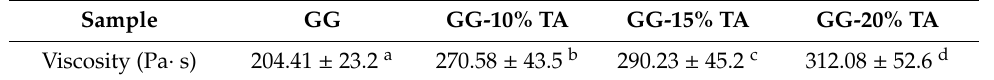
Table 2. Viscosity of GG and various GG-TA solutions.